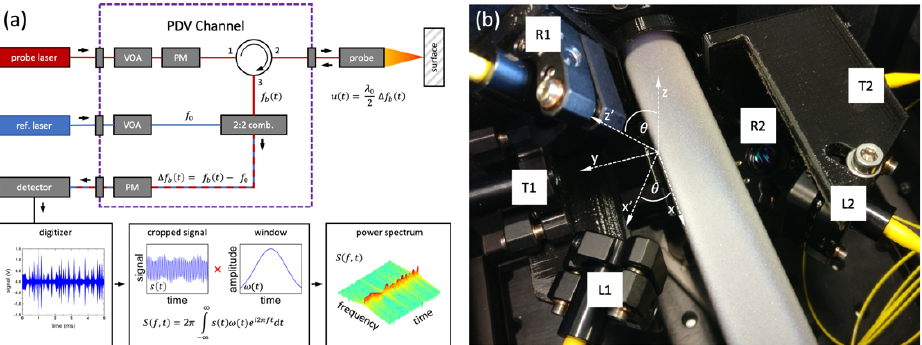
Fig. 2 .: (a) Schematic of the PDV channel and the data analysis process; (b) three pairs of probes located inside each PDV enclosure for the measurements of longitudinal (L1 & L2), rotational (R1 & R2) and transverse (T1 & T2) motions,